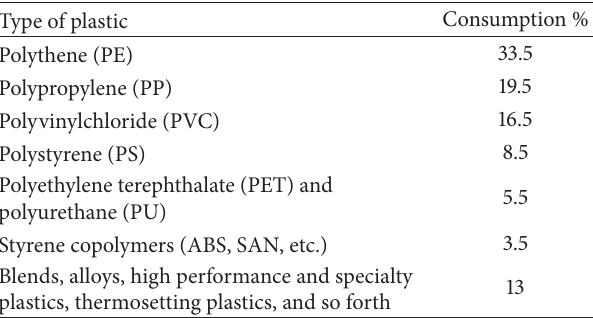
Table 1: Global consumption of individual plastics